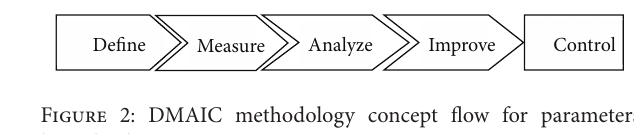
Figure 2: DMAIC methodology concept flow for parameters